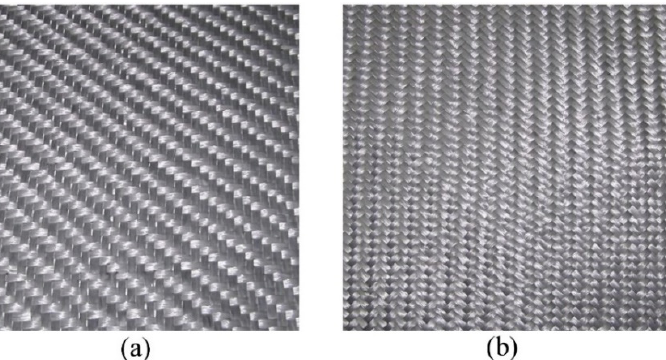
Figure 10. PP-GF fabrics investigated by Formisano et al.’s research [8]: ( a ) 0/90 ply and ( b ) ± 45 ply. Adapted with permission from Reference [51].